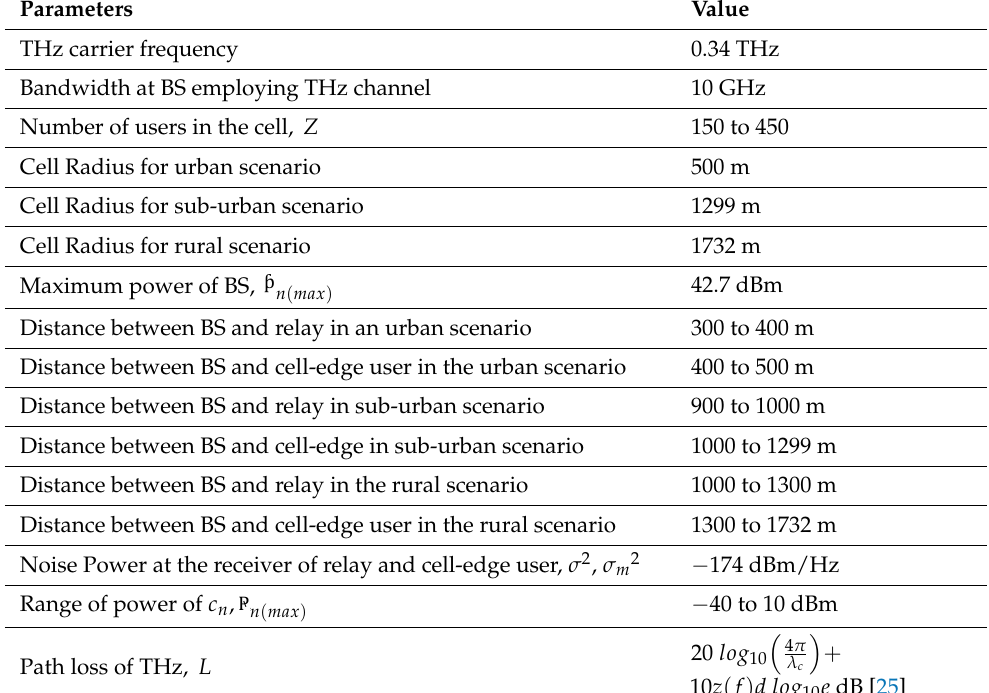
Table 3. Numerical Parameters. Table 2. Notations.